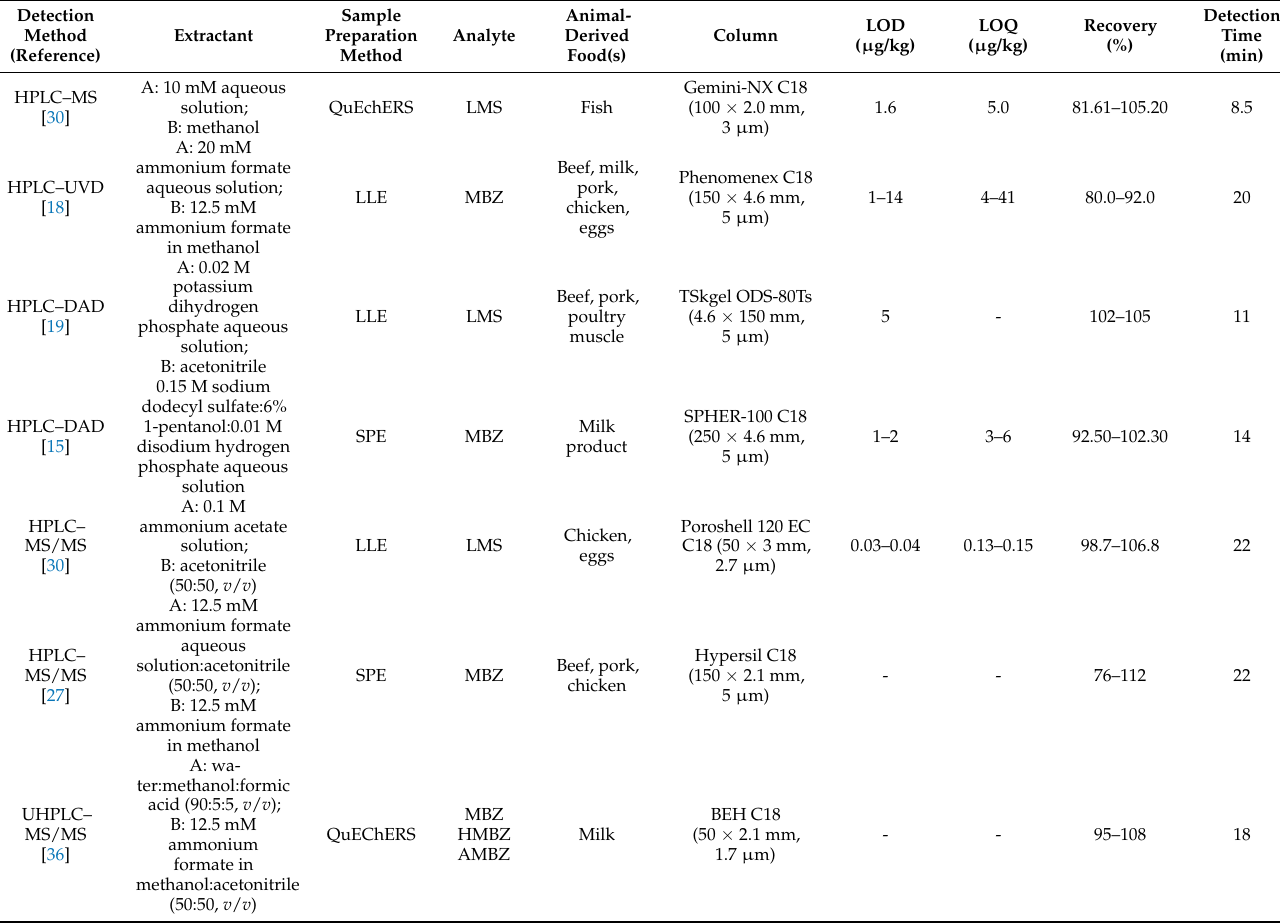
Table 9. Comparison of the present method with other reported